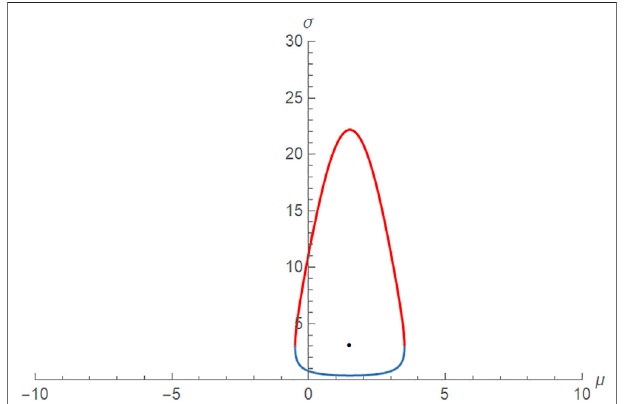
FIGURE 6 | Geodesic locus: Points at a distance 2 from (1.5, 3) with A = 1, Z =0.6. This is our metric “ circle. ”